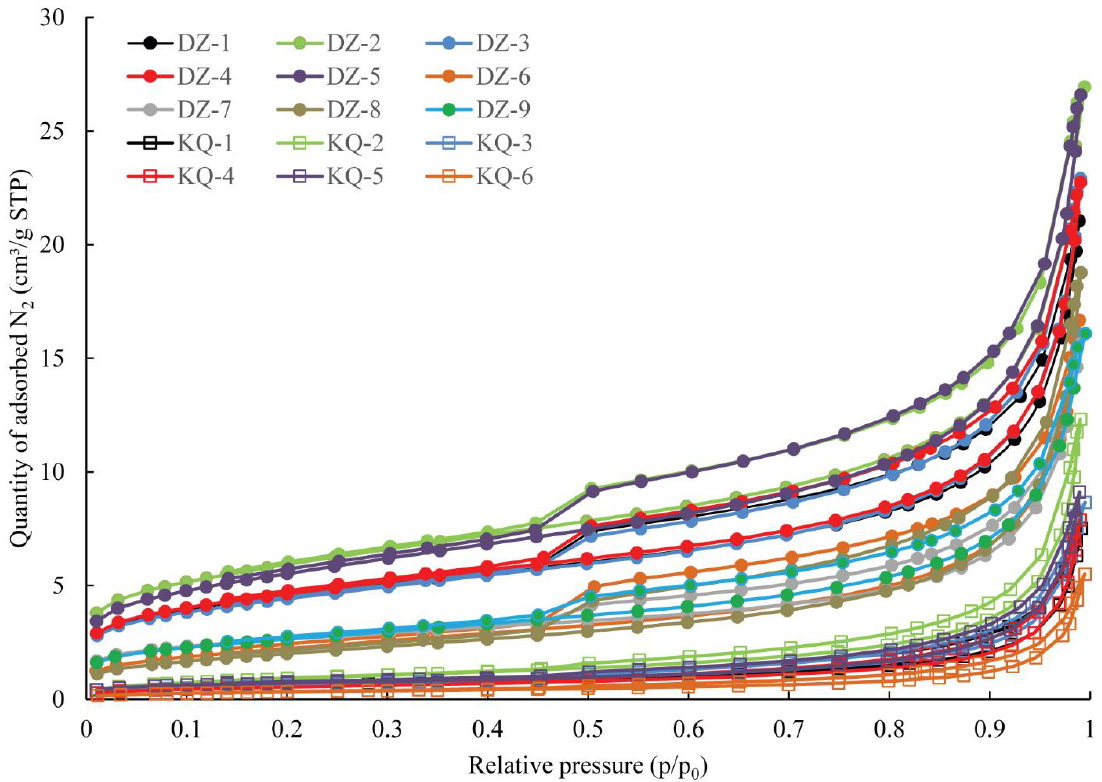
Figure 4. N 2 adsorption isotherms of the studied Chang 7 Member shale samples.